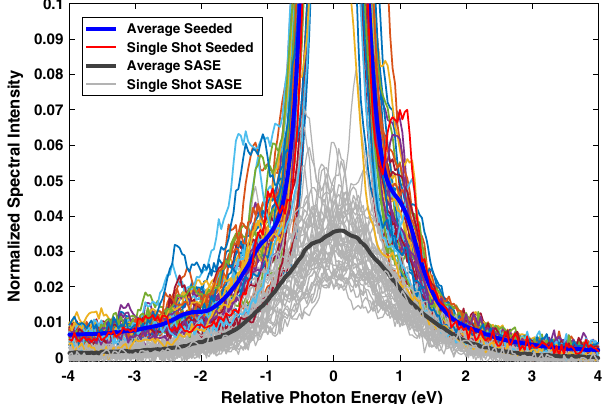
FIG. 7. Average and individual shot spectra at the end of U19 for the November 2017 shift from both self-seeded (colored lines) and blocked seed (i.e., SASE only; grey lines) datasets; the LH energy was 12 μ J. The individual shots were randomly selected from those whose E B fell in the central FEL resonance region. All spectra are normalized to the peak value of the average spectrum of the E B -filtered self-seeded dataset. There is no correction here nor in the following plots for PSF-induced “ leakage ” into the pedestal region from the amplified seed.